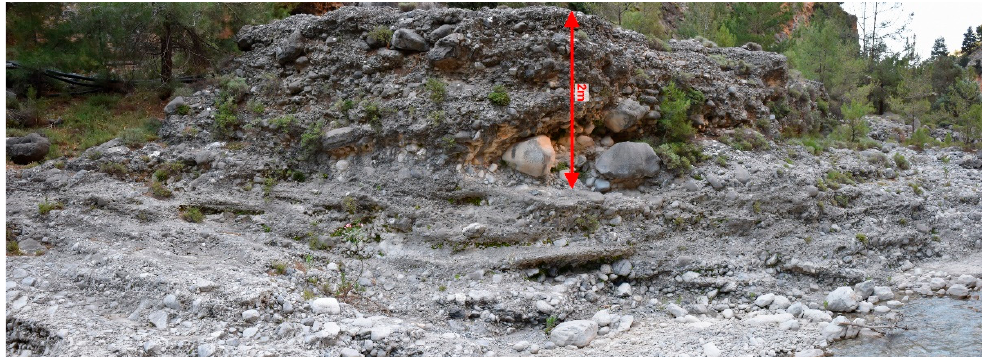
Figure 8. Representative post-Alpine formations of various thicknesses, documented throughout the Samaria Gorge area.